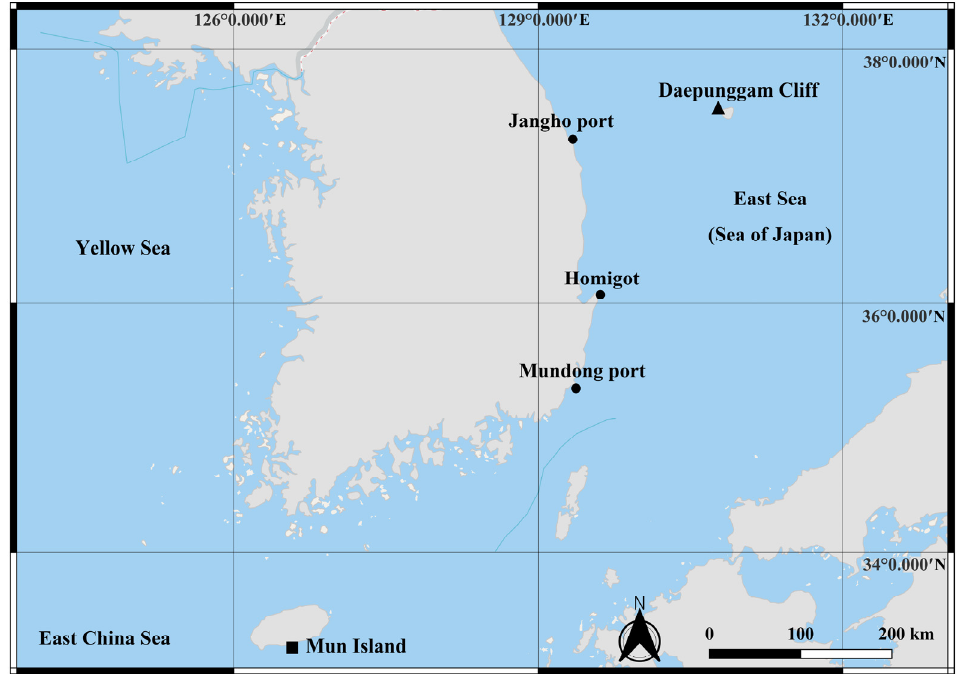
Figure 1. Sample collection sites on the Korean Peninsula and the adjacent sea. Black square: Mun Island south of Jeju Island. Black circles: Inland collection sites along the east coast of the Korean Peninsula, Mudong port, Homigot, and Jangho port. Black triangle: Daepunggam Cliff of Ulleung Island.